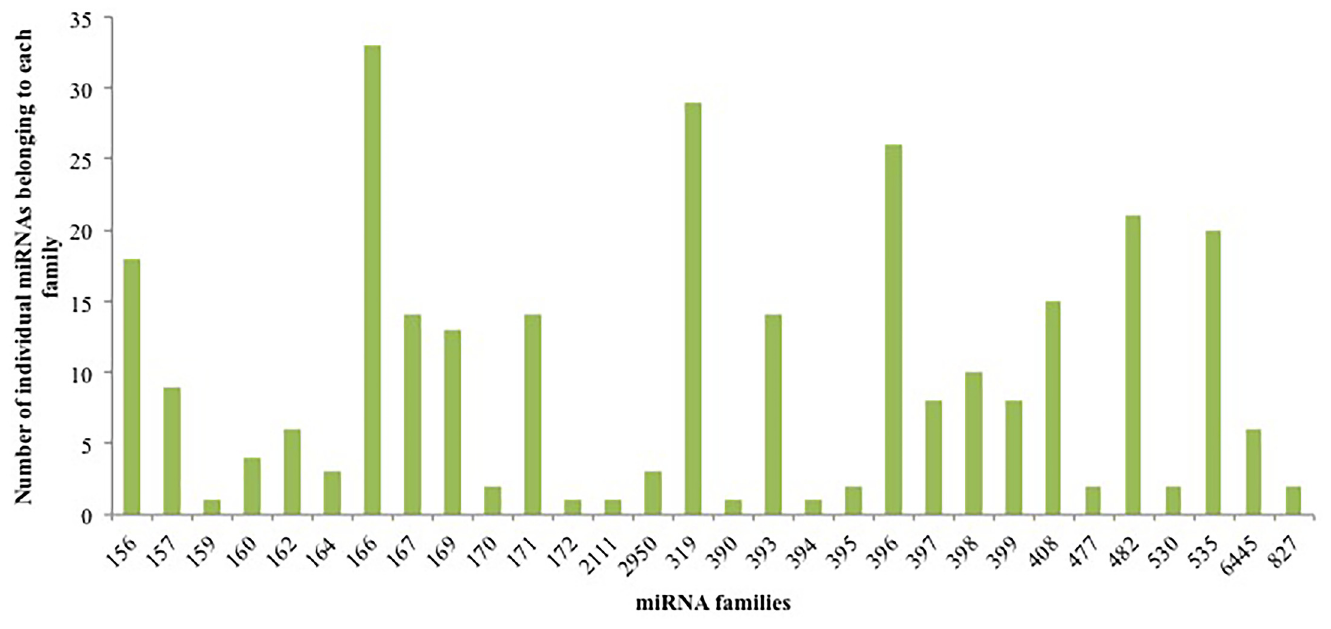
Fig 3. The number of conserved individual miRNAs belonging to each miRNA family identified in cassava T200 and TME3 from deep sequencing the NGS data and are highlighted in green in S1 Table. We were also able to identify 9 (28.1%)